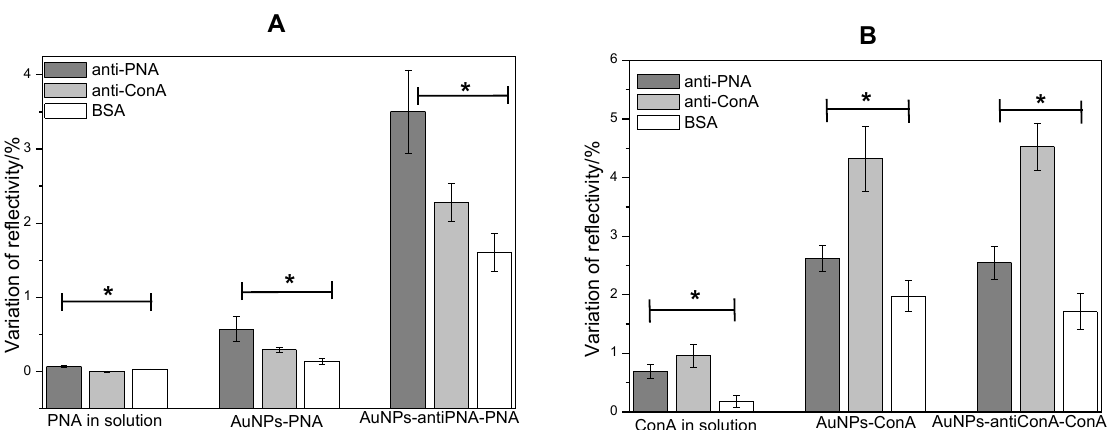
Figure 8. Mean values and standard deviation of the variation of reflectivity on spots of antibody anti-PNA ( A ) and antibody anti-ConA ( B ) after the injection of PNA ( A ) and ConA ( B ) at the concentration of 95 nM in solution, covalently linked to gold NPs and captured by gold NPs functionalized with anti-PNA or anti-ConA. * Values significantly different (ANOVA, p <